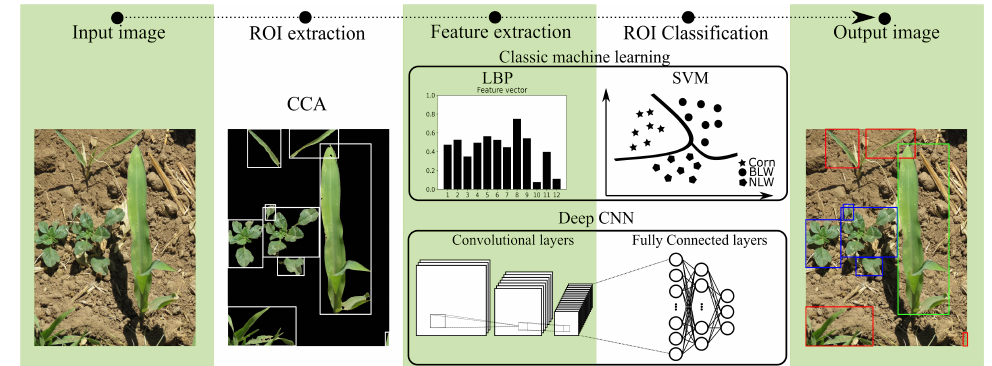
Figure 1. General description of the methodology for weed classification in actual corn fields (green box: Crop, red box: NLW and blue box: BLW).